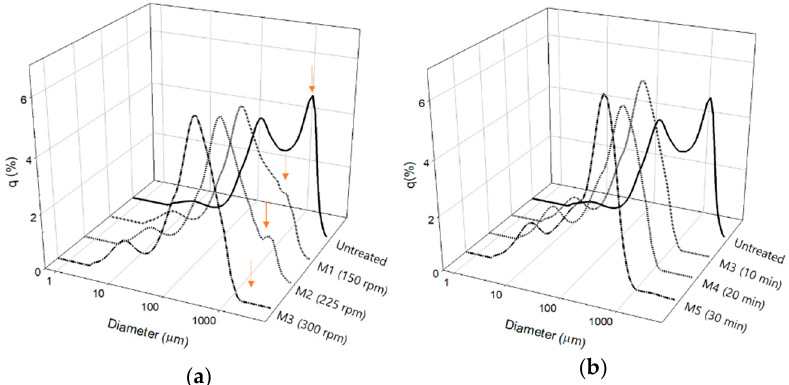
Figure 1. Size distributions of pretreated food waste based on ( a ) milling speed and ( b ) milling